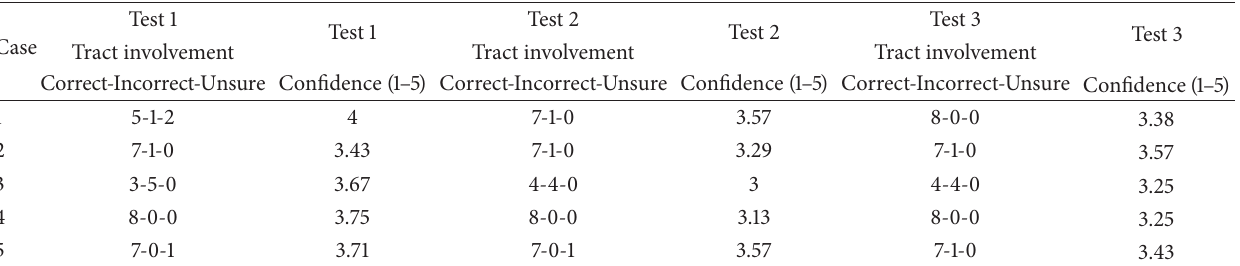
Figure 5: A 43-year-old female with breast cancer metastasis to the posterior right frontal lobe. (Case 1): (a) axial T1 postgadolinium; (b) grayscale FA (GSFA) map; (c) color coded orientation map (CCOM); and (d) stereoscopic view. There was an increase from 5 of 8 to 8 of 8 correct responses regarding white matter tract involvement between the GSFA map and VM nonstereoscopic and stereoscopic maps. Table 3: Study results—questions 4 and